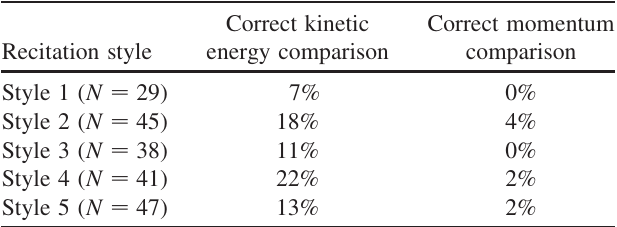
TABLE II. Student performance on two pretest